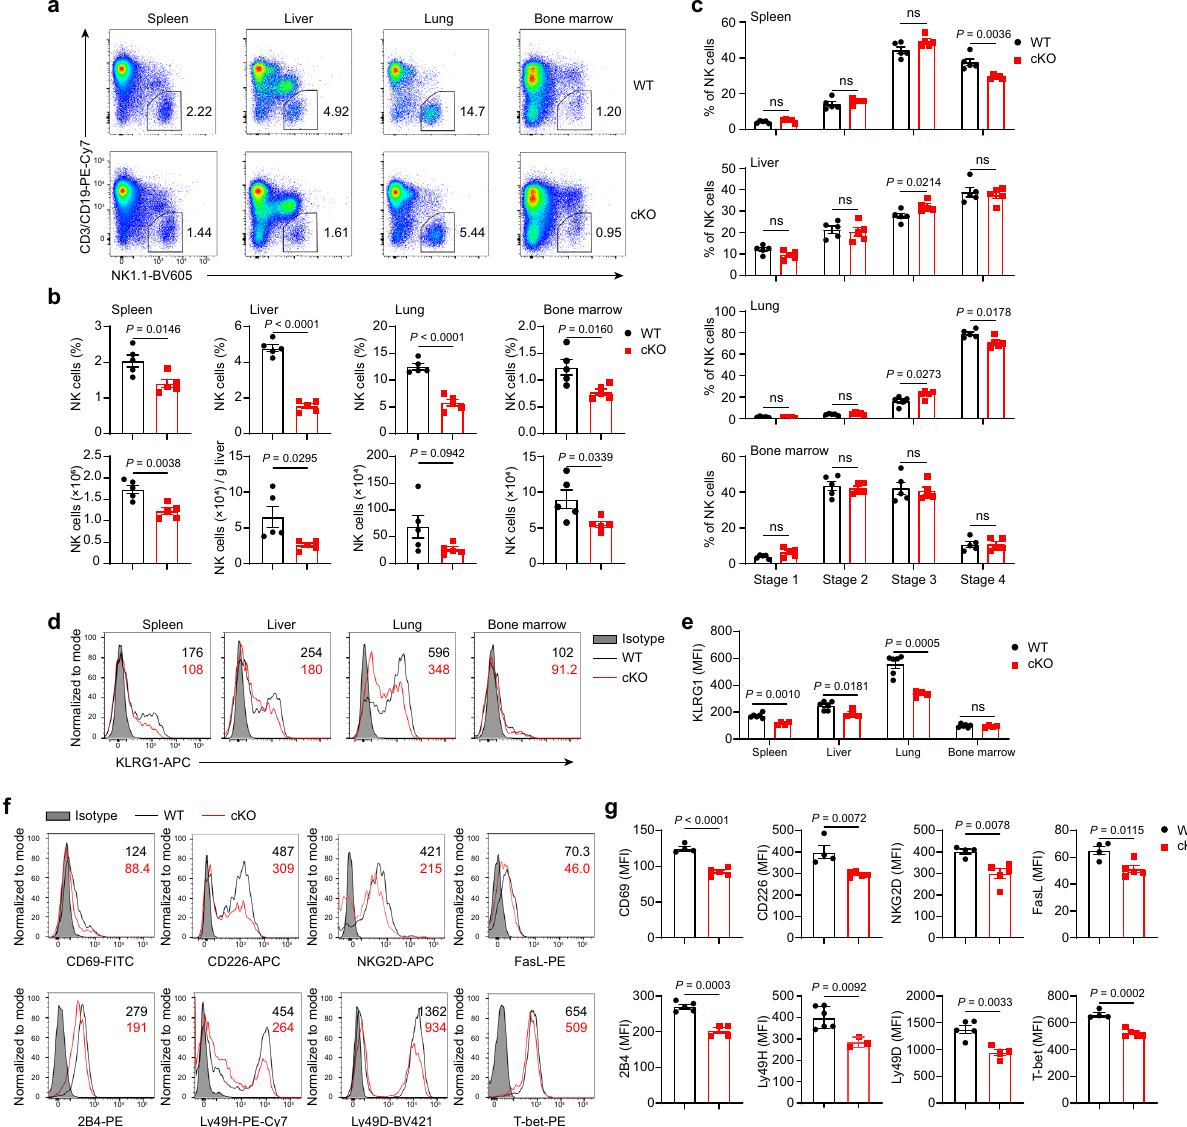
Fig. 3 METTL3 de fi ciency disturbs NK cell homeostasis at a steady state. a Representative plots showing expression of NK1.1 and CD3/CD19 in mononuclear cells from the indicated organs of WT and cKO mice. b Percentages and absolute numbers of NK cells in the indicated organs from WT and cKO mice ( n = 5/group). c Percentages of NK cells at different stages in the indicated organs of WT and cKO mice ( n = 5/group). (Stage 1: CD27 − CD11b − ; stage 2: CD27 + CD11b − ; stage 3: CD27 + CD11b + ; stage 4: CD27 − CD11b + ). d , e Representative histograms ( d ) and MFI ( e ) of KLRG1 expression in NK cells from the indicated organs of WT ( n = 6) and cKO ( n = 4) mice. f , g Representative histograms ( f ) and MFI ( g ) of expression of the indicated molecules in splenic NK cells from WT ( n = 5 for 2B4 and Ly49D, n = 6 for Ly49H, and n = 4 for other molecules) and cKO mice ( n = 3 for Ly49H, n = 4 for 2B4 and Ly49D, and n = 5 for other molecules). Each symbol represents an individual mouse ( b , c , e , g ). Data are the mean ±SEM (ns, not signi fi cant; unpaired two- tailed t -test). Source data are provided as a Source Data fi le. Data represent two ( d , e ) or at least three independent experiments ( a – c , f , g